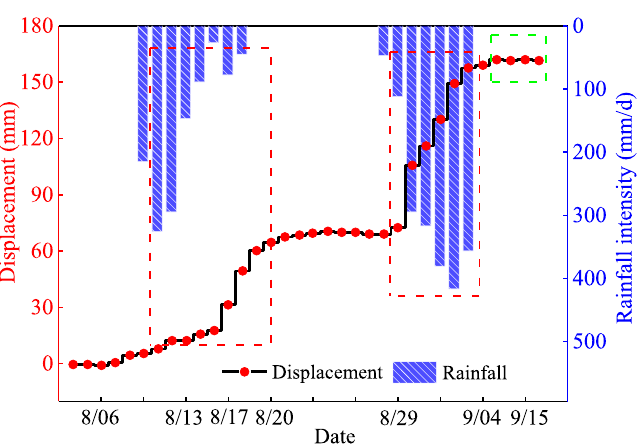
Figure 15. Displacement of anti-slide pile top (excavation platform I, near the section K28 + 426) during and after